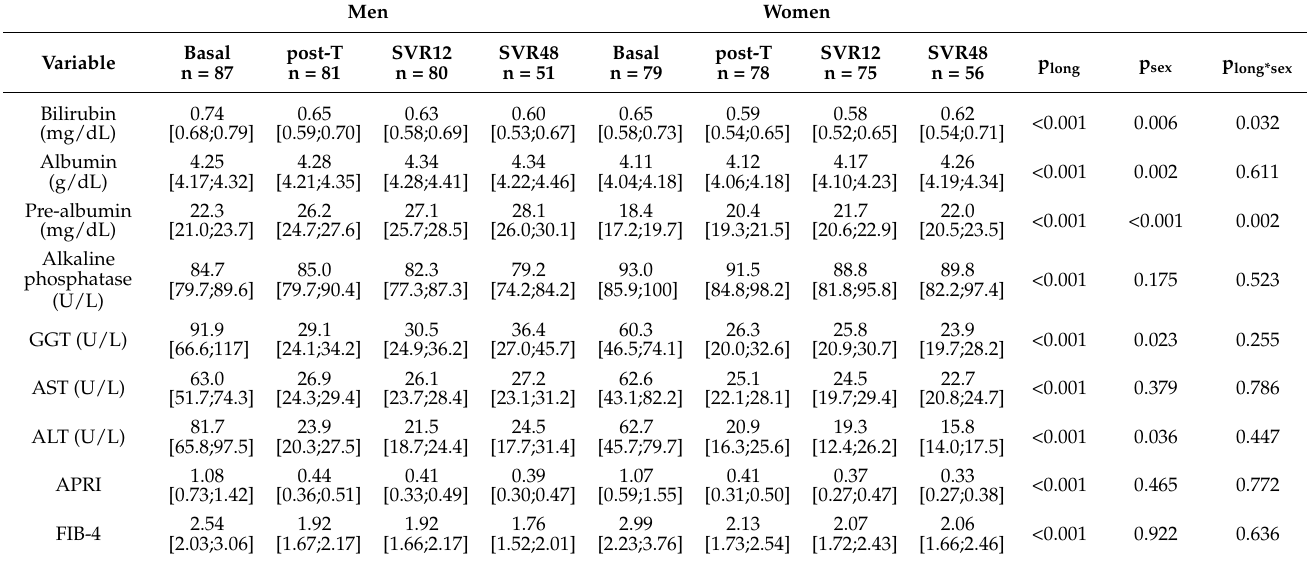
Table 3. Hepatic changes from baseline to